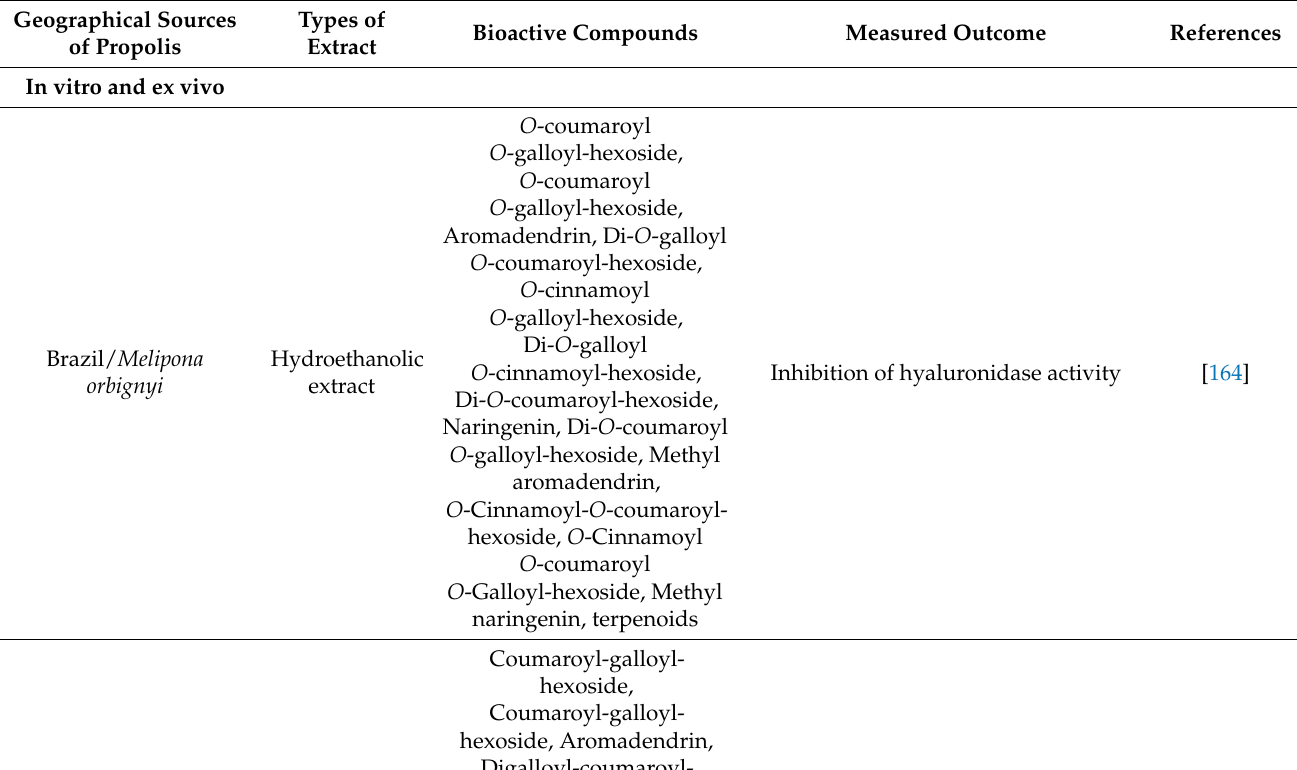
Table 8. Anti-inflammatory properties of propolis in other types of